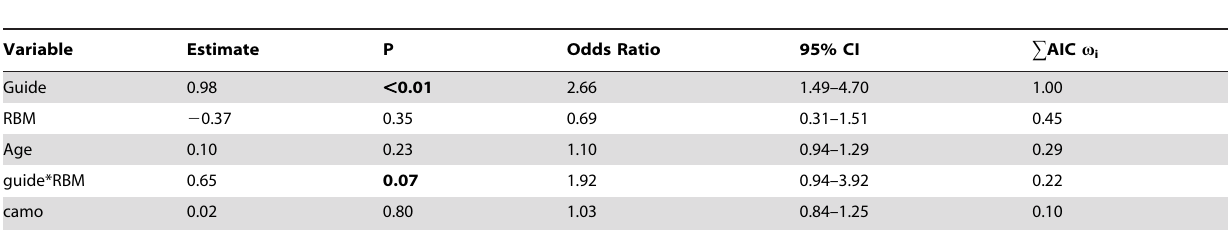
Table 2. Model-averaged parameter estimates and relative importance derived from inference across the top model set.